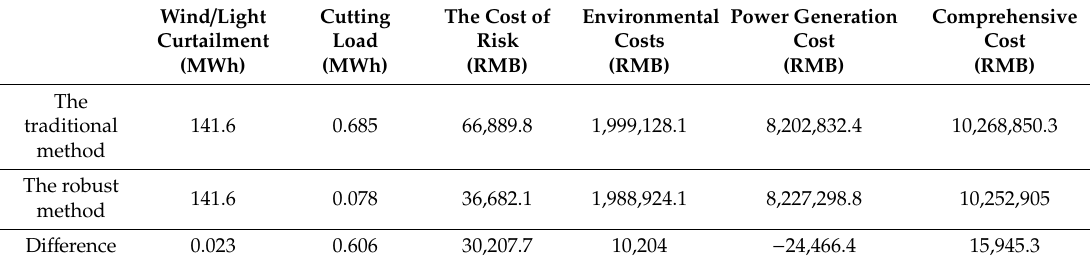
Table 2. Comparison between di ff erent methods when the uncertainty set is